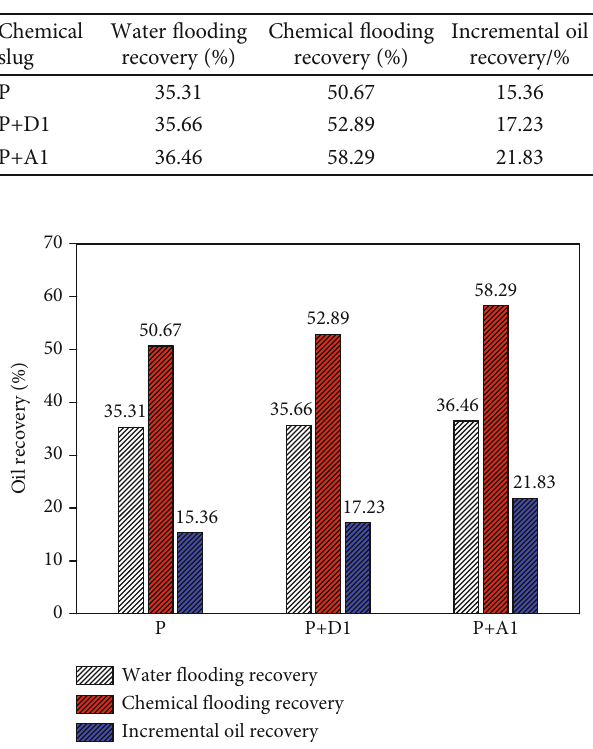
Figure 12: The remaining oil distribution at the end of water fl ooding and polymer-viscosity reducing surfactant combination fl ooding. Table 4: The incremental oil recovery results at di ff erent fl ooding stages for micromodel fl